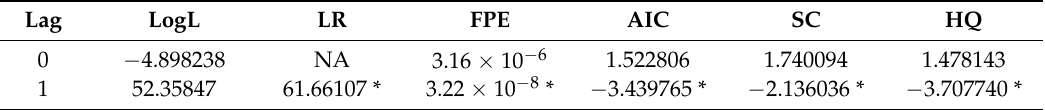
Table 12. Lag selection criteria for coal mining and